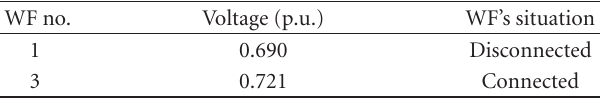
Table 3: Results obtained with proposed controller in the case of